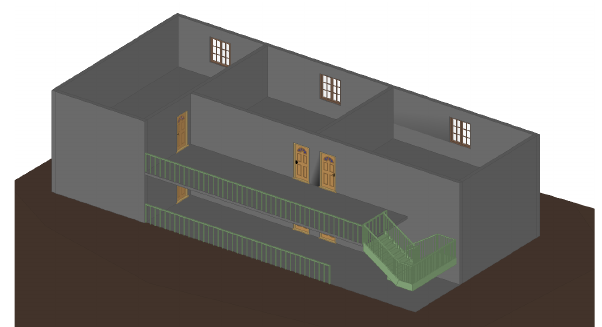
Figure 2. Building with physical boundary.